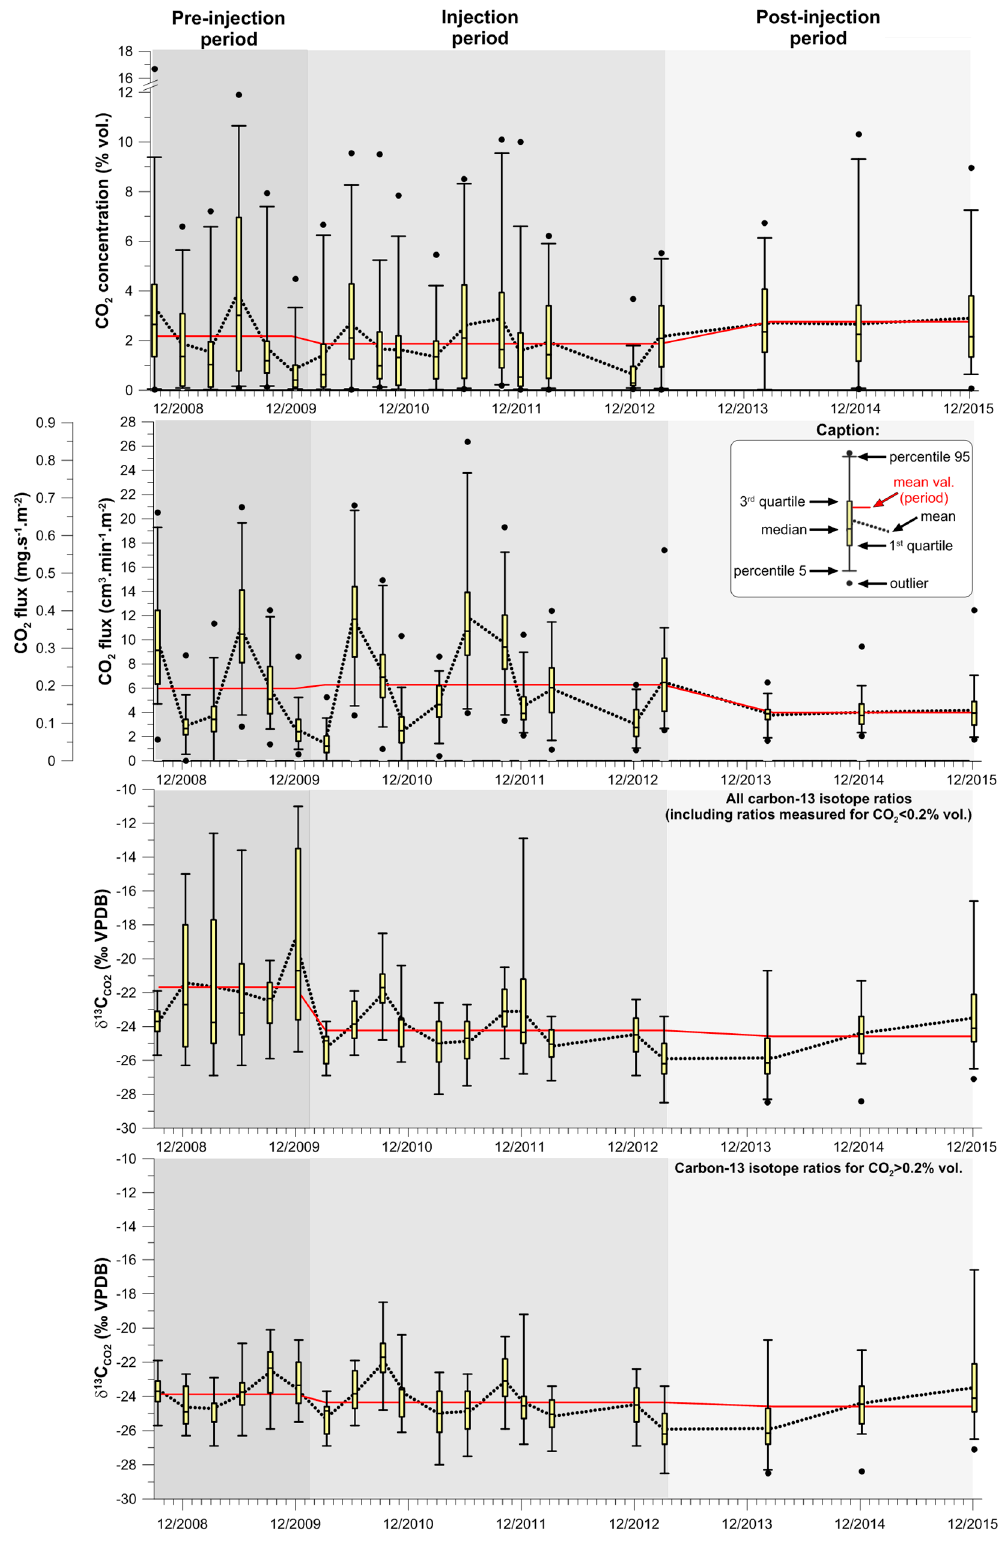
Figure 3. From top to bottom: soil CO 2 concentration, soil-gas flux at the soil/atmosphere interface, δ 13 C isotope ratios of the CO 2 in soil gas (all data), and 13 C isotope ratios of CO 2 in soil gas (excluding CO 2 <0.2%). Data are shown as box plots presenting median value, quartiles and outliers. Mean values indicated by the red line correspond to the mean values calculated for each pilot phase (pre-injection, injection and post ‐ injection).